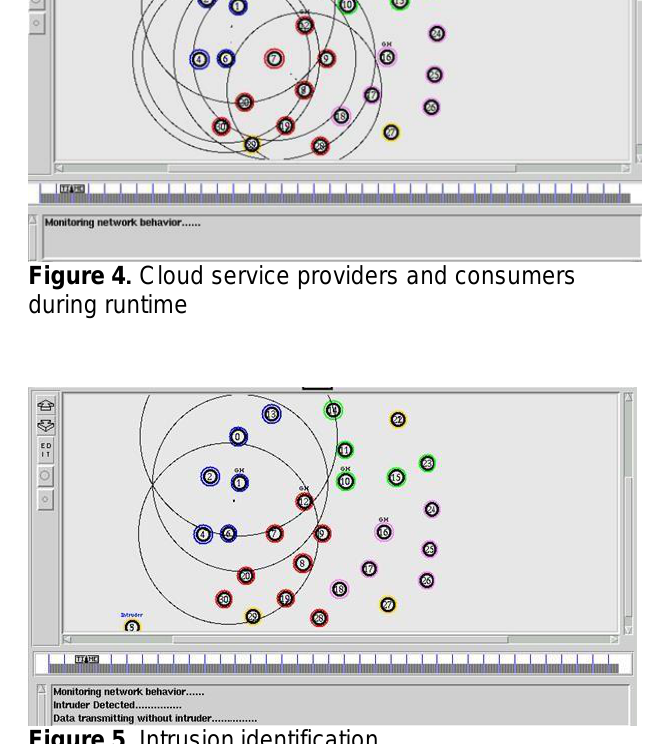
Figure 5 . Intrusion identification